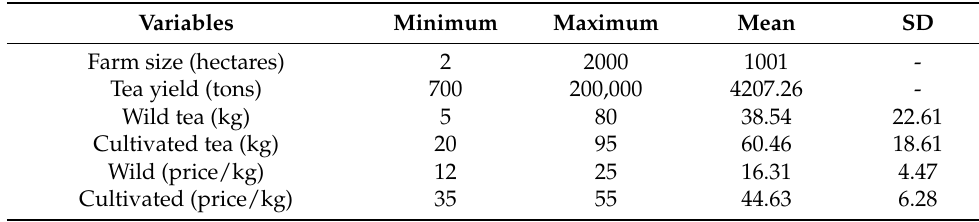
Table 4. Rooibos farming